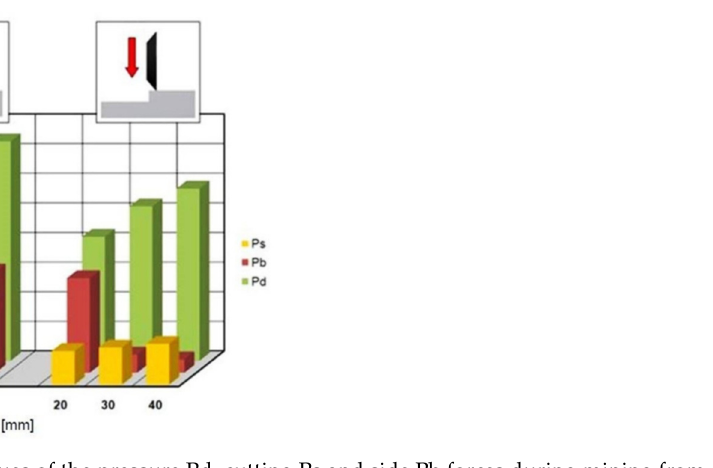
Figure 16. Mean values of the pressure Pd, cutting Ps and side Pb forces during mining from the left and right side of the block at mining depth g 15 mm [30].